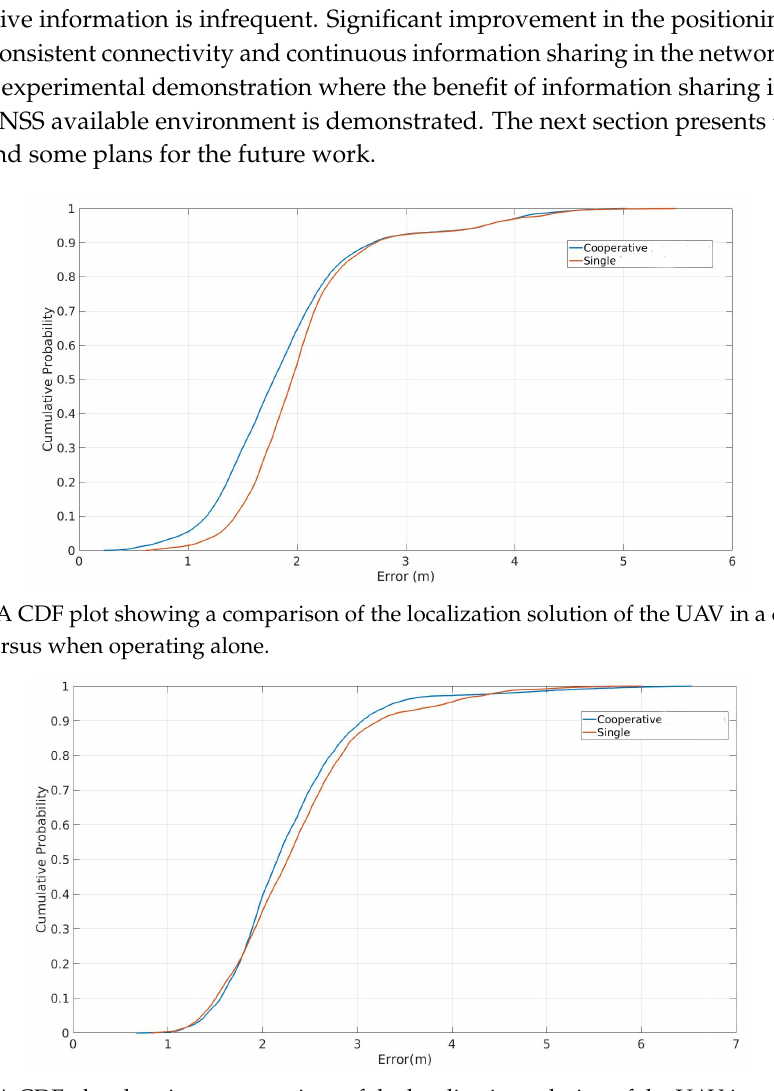
Figure 31. A CDF plot showing a comparison of the localization solution of the UAV in a cooperative network versus when operating alone for another repetition of the same